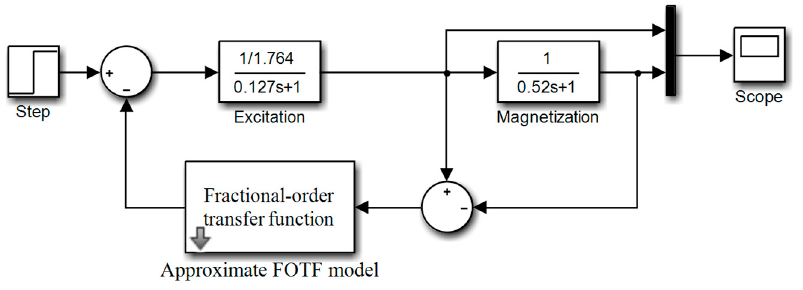
Figure 10. Structural model of the impact of eddy currents by the approximation of R ω by means of the fractional order block.